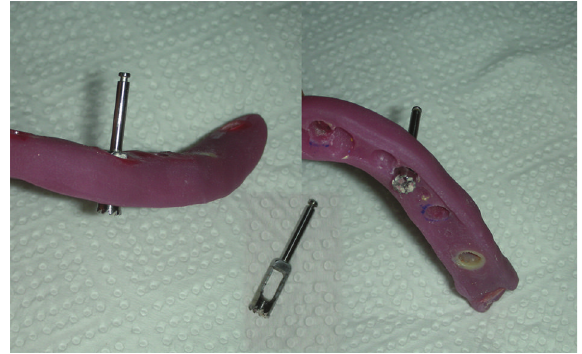
Figure 4: Excision of bone cylinders from the mandibular body using a slow speed trephine